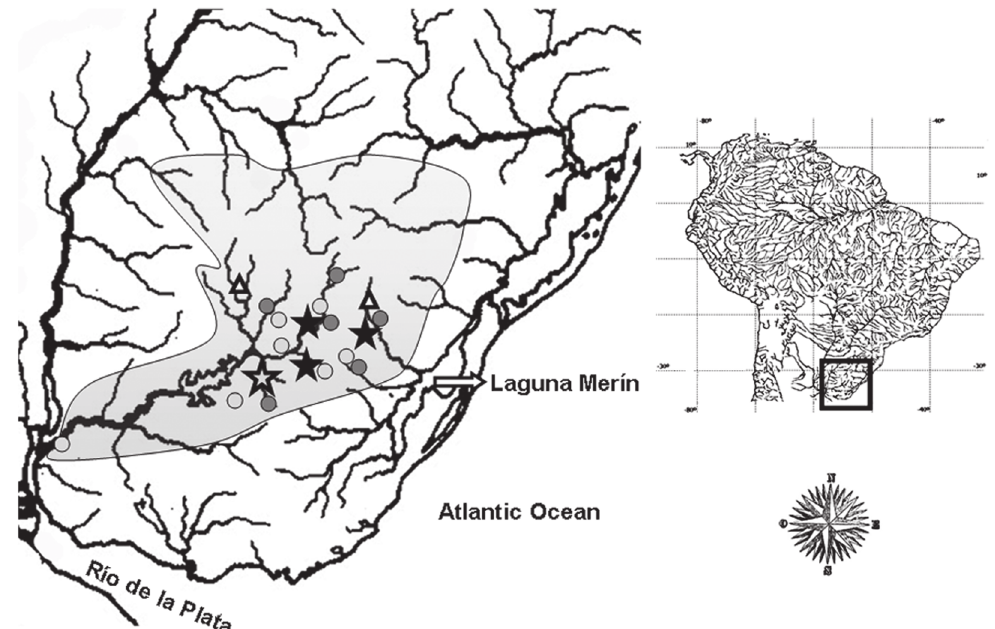
Fig. 4. Distribution of Austrolebias quirogai (stars); empty star indicates type locality. Distribution data of A . arachan (light gray circles), A . vazferreirai (dark gray circles), A. melanoorus (white triangles), and the A. affinis species group (gray shaded area) were obtained from ZVC-P catalogue database, Costa (2006), and Volcan et al . (2010); each point may represent more than one